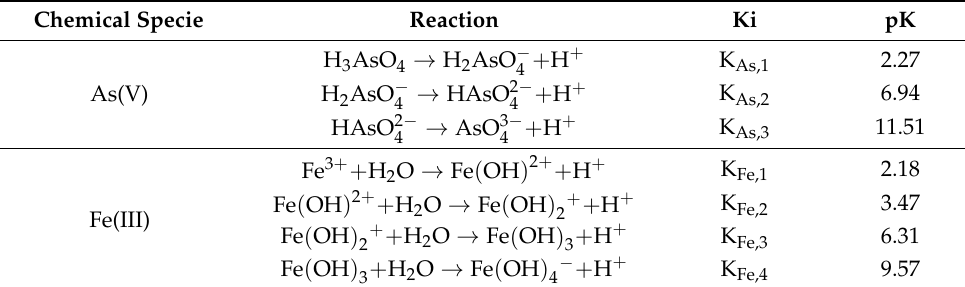
Table 1. Hydrolysis constants for arsenate and ferric iron at 70 ◦ C [37]. Chemical